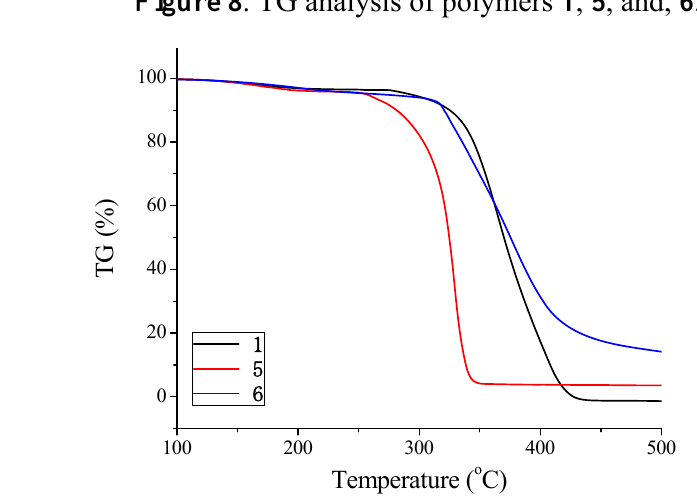
Figure 8 . TG analysis of polymers 1 , 5 , and, 6